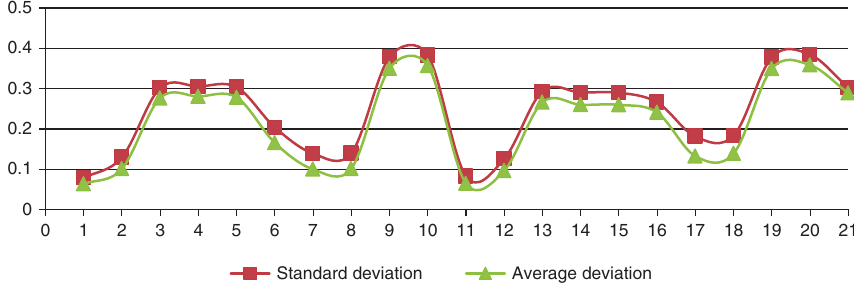
Figure 7: Standard/Average Deviation Results for Proposed 21 Measures on Score Classes 4–5 with MSR Paraphrase.